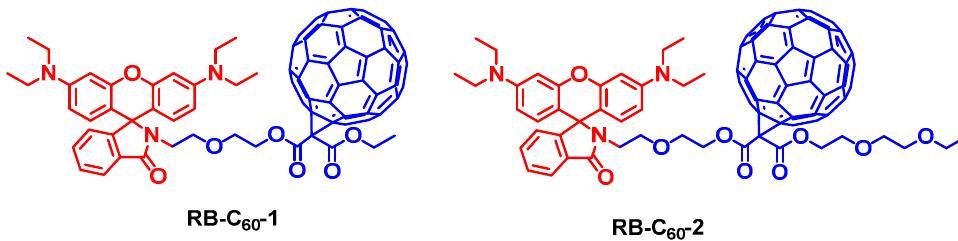
Figure 18. Rhodamine-C 60 dyads showing acid-activatable 1 O 2 production capability. Only the opened form shows a strong absorption of visible light.